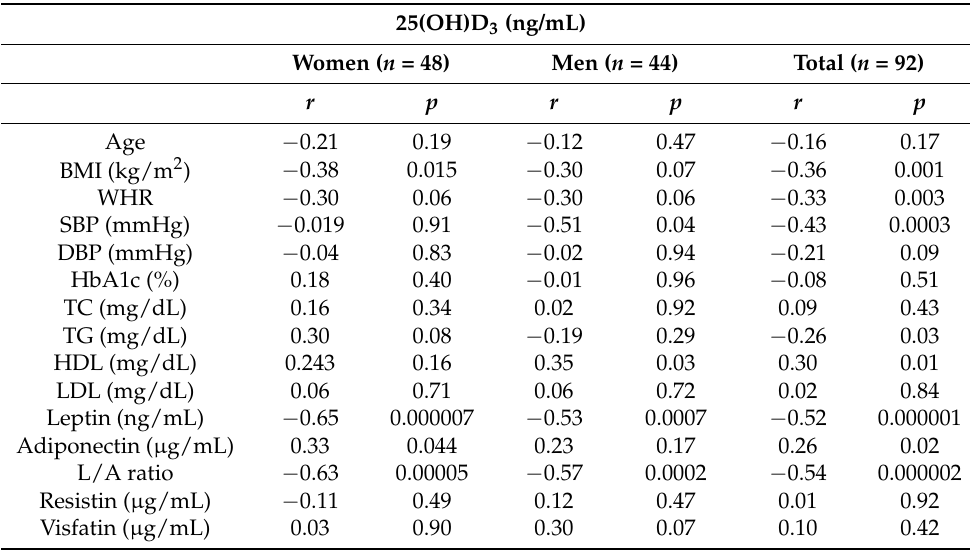
Table 2. Correlations between 25-hydroxyvitamin D 3 and anthropometric indices, biochemical parameters as well as adipokines among type 2 diabetic